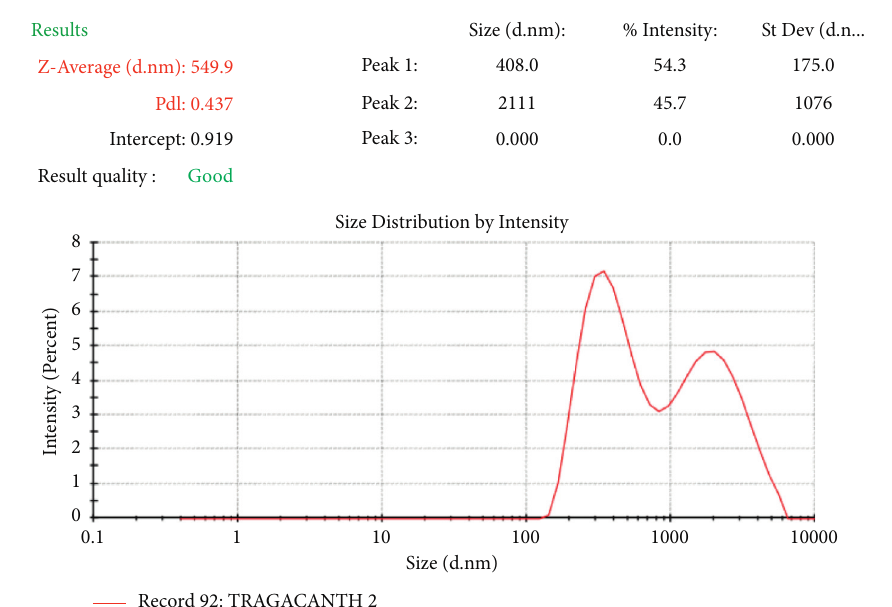
Figure 8: Droplet size and polydispersity index (PdI) of tragacanth gum emulsion.